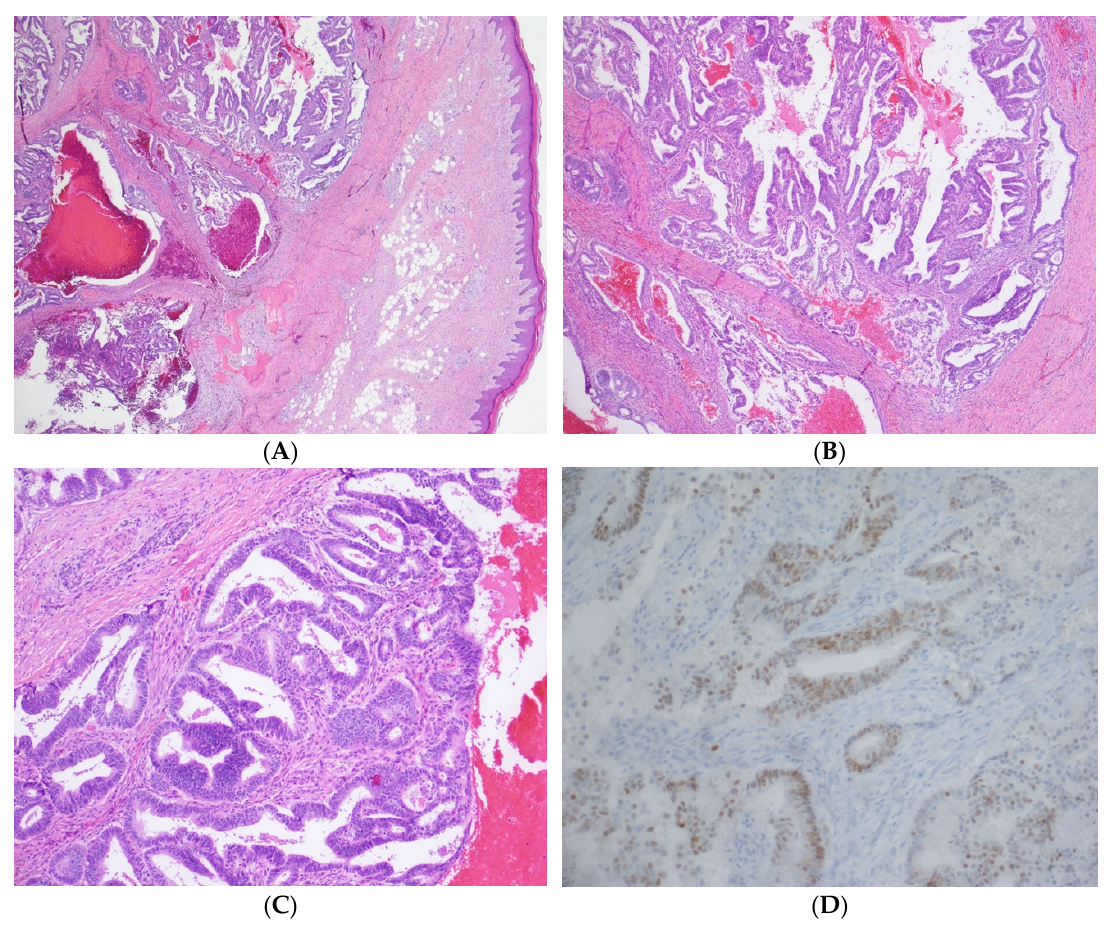
Figure 4. ( A ) 20× magnification: The image shows a subcutaneous mass consisting of endometrial glands and stroma in and around bone. ( B ) 40× magnification: The tumor has endometrial glands with complex architecture, including papillary and cribriform growth patterns. ( C ) 100× magnification: At higher power, the glands have pseudostratified columnar cells with round nuclei. Note the hemorrhage and endometrial stroma. ( D ) 200× magnification: The cells are positive with PAX8 immunohistochemical stain, consistent with the known endometrial adenocarcinoma primary.